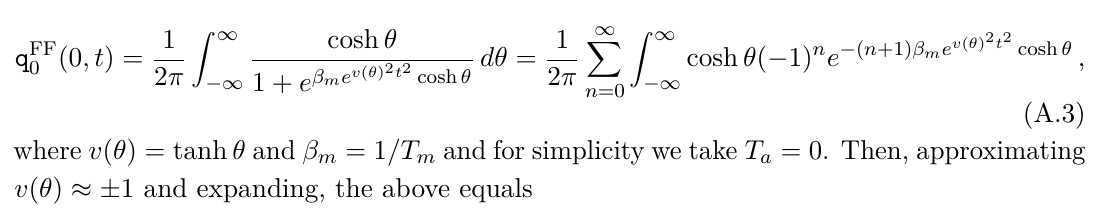
( x, t ) as a function of x for small values of t = 0 , 0 . 2 , 0 . 4 , 0 . 6 , 0 . 8 and 1 Figure 20 . The function q FF 0 (Left) and for larger values t = 0 , 1 , 2 , 3 , 4 , 5 and 6 (Right). can be analytically obtained from (A.1)